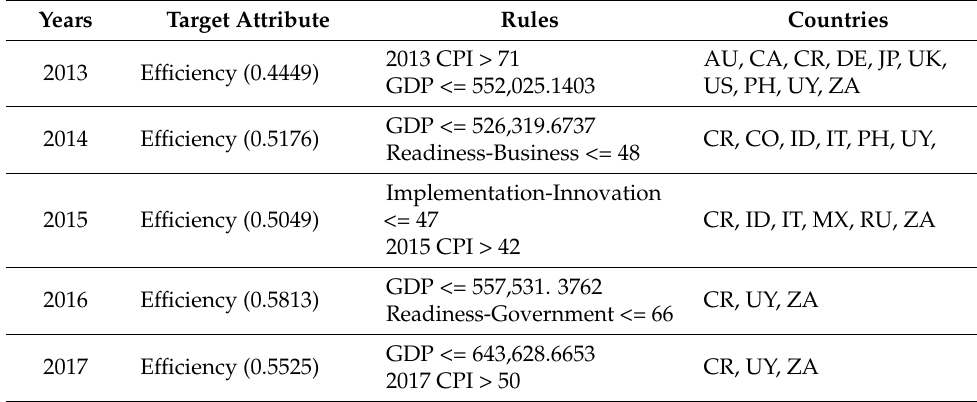
Figure 6. BCG matrix for the Anti-corruption efficiency in total. Table 8. Results of association rules analysis for each